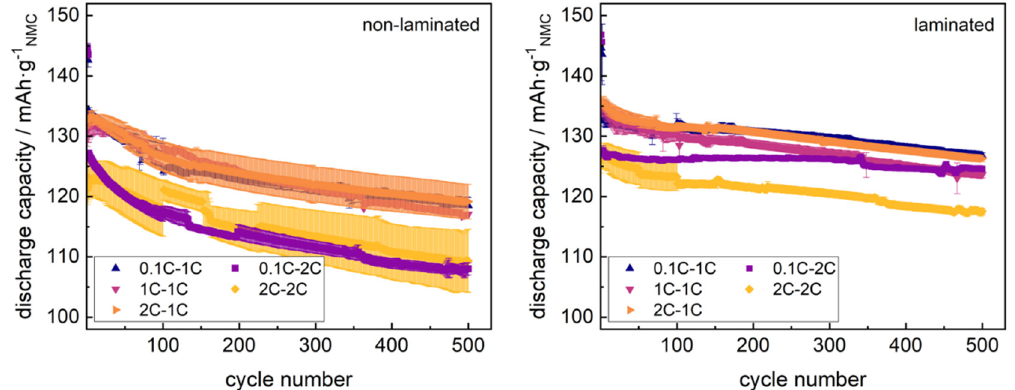
Figure 1. Averaged discharge capacity data of non-laminated / laminated cells in cycling test (500 cycles) after varied formation rate (2 initial cycles); error bars indicated.